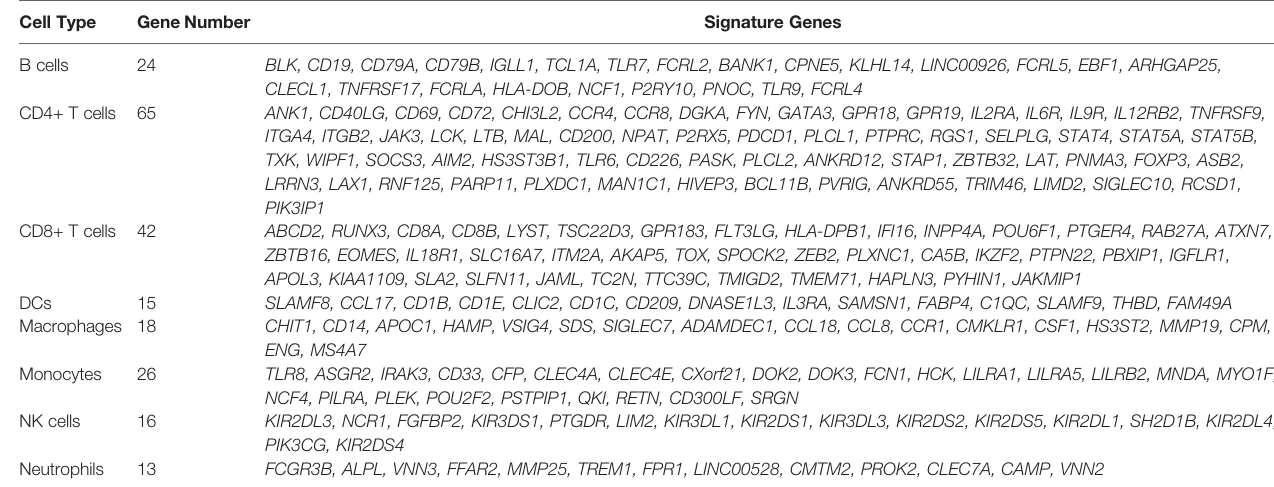
TABLE 2A | A speci fi c gene set compared with CRC cells for per cell type was selected and used in TICPE.